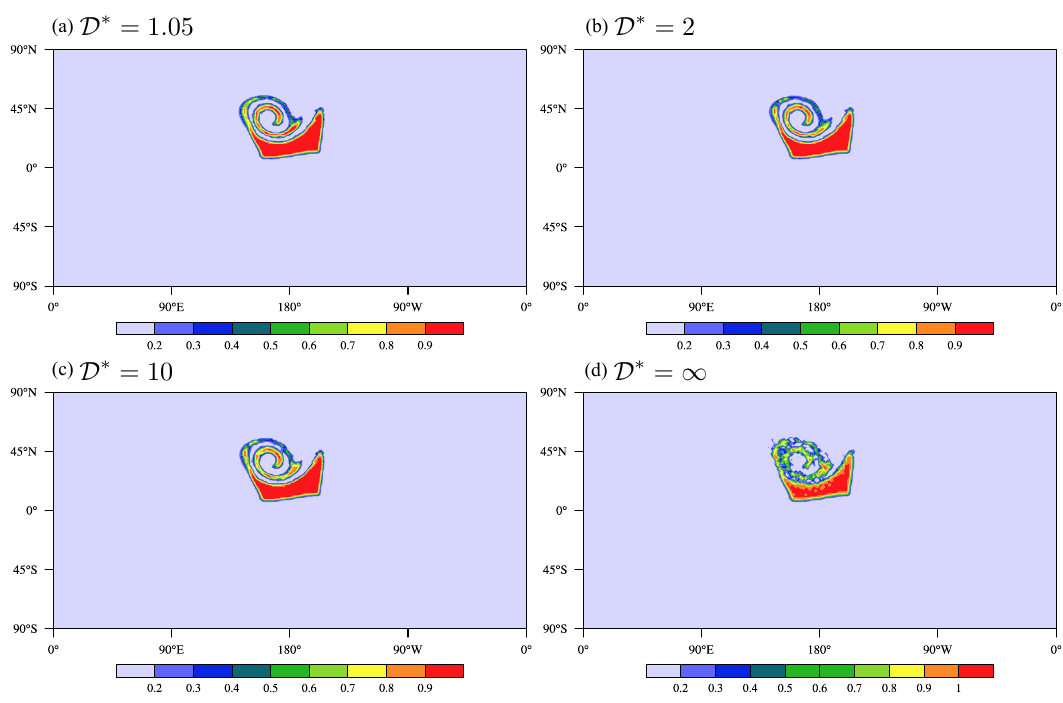
Figure 16. The effectiveness of the interparcel mixing adaptivity. Different disorder degree threshold D ∗ are tested. (a) is the same as Fig.